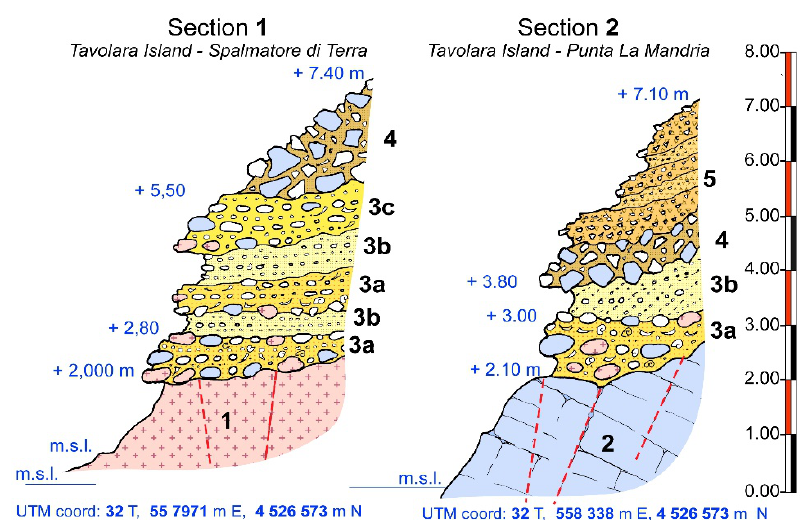
Figure 10. Stratigraphic sections of the MIS 5.5 littoral deposits in Tavolara Island, in front of the Olbia coastal plain. (1): Section of Spalmatore Baya (Section 1), inequigranular medium-grained pink leucogranites with phenocrysts of quartz and K Feldspars (Upper Carboniferous). (2) Section of Punta La Mandria (Section 2), dolomite arenaceous, dolomitic limestone from coasts to circalittoral, with foraminifera and red algae (Dorgali Formation, Middle Jurassic). (3a) Polygenic heterometric conglomerate with alternating quartz micro-conglomerates in fossiliferous arenaceous matrix (MIS5); (3b) sandstones and micro-conglomerates mainly quartz, fossiliferous with plane-parallel and foreset lamination (MIS5); (3c) heterometric conglomerate of granite and dolomite blocks, in an arenaceous matrix with carbonate cement. (4) Well-cemented landslide deposit (MIS 4-3?). (5) Deposit of stratified slope with alternations of Eboulis ordonnés and Grezes litees (LGM-MIS 2). The sedimentary sequence of MIS 5.5 at Punta La Mandria has a lower thickness and rests discordantly on both Paleozoic granitoid substrate and Middle Jurassic arenaceous